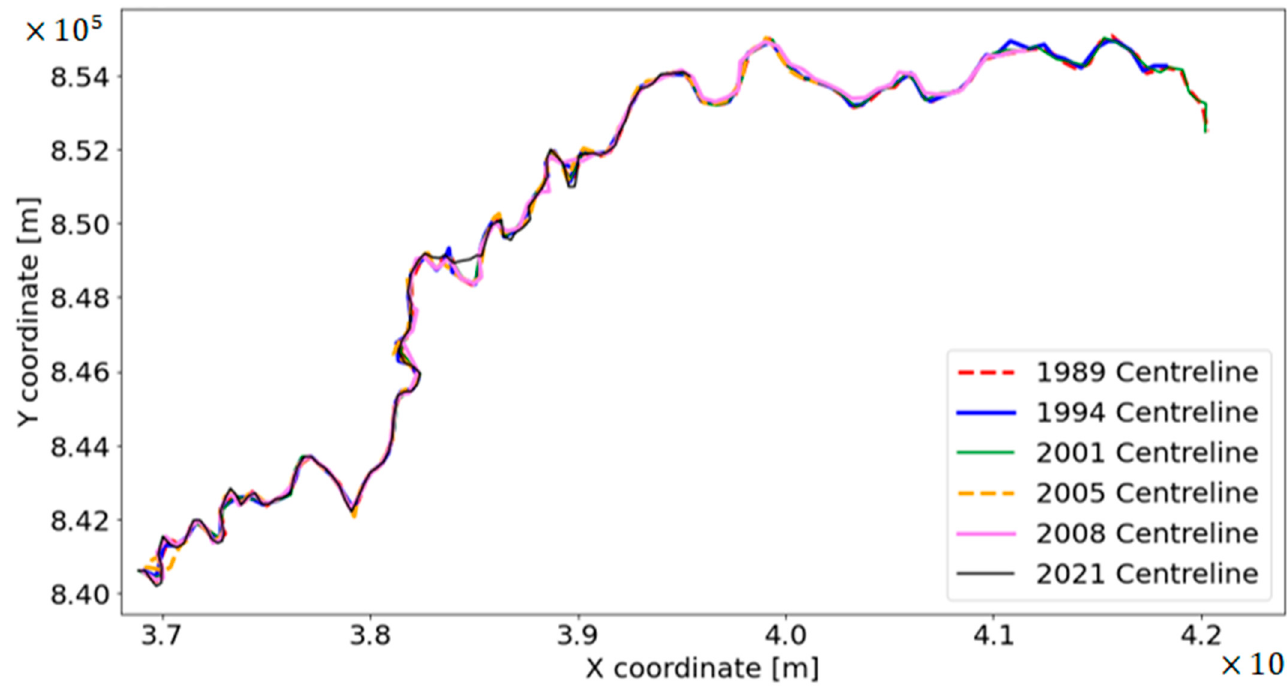
Figure 6. Temporal variation of river centerline.